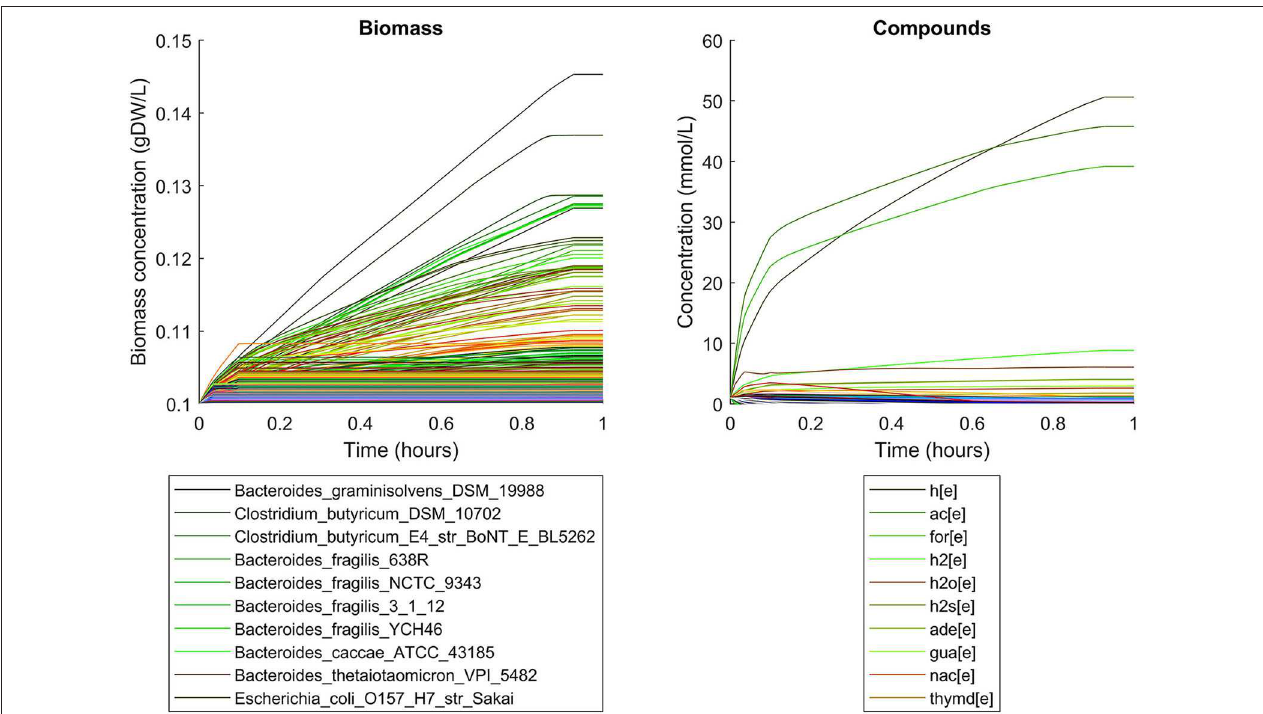
FIGURE 5 | Simulating batch growth of a 773 species gut microbiome with 166 compounds, using identical initial biomass concentrations for all species and identical compound concentrations for all compounds. The legends only account for the 10 most abundant entities at the end of the simulation, with compound abbreviations h[e]: proton, ac[e]: acetate, for[e]: formate, h2[e]: hydrogen, h2o[e]: water, h2s[e]: hydrogen sulfide, ade[e]: adenine, gua[e]: guanine, nac[e]: nicotinate, thymd[e]: thymidine.